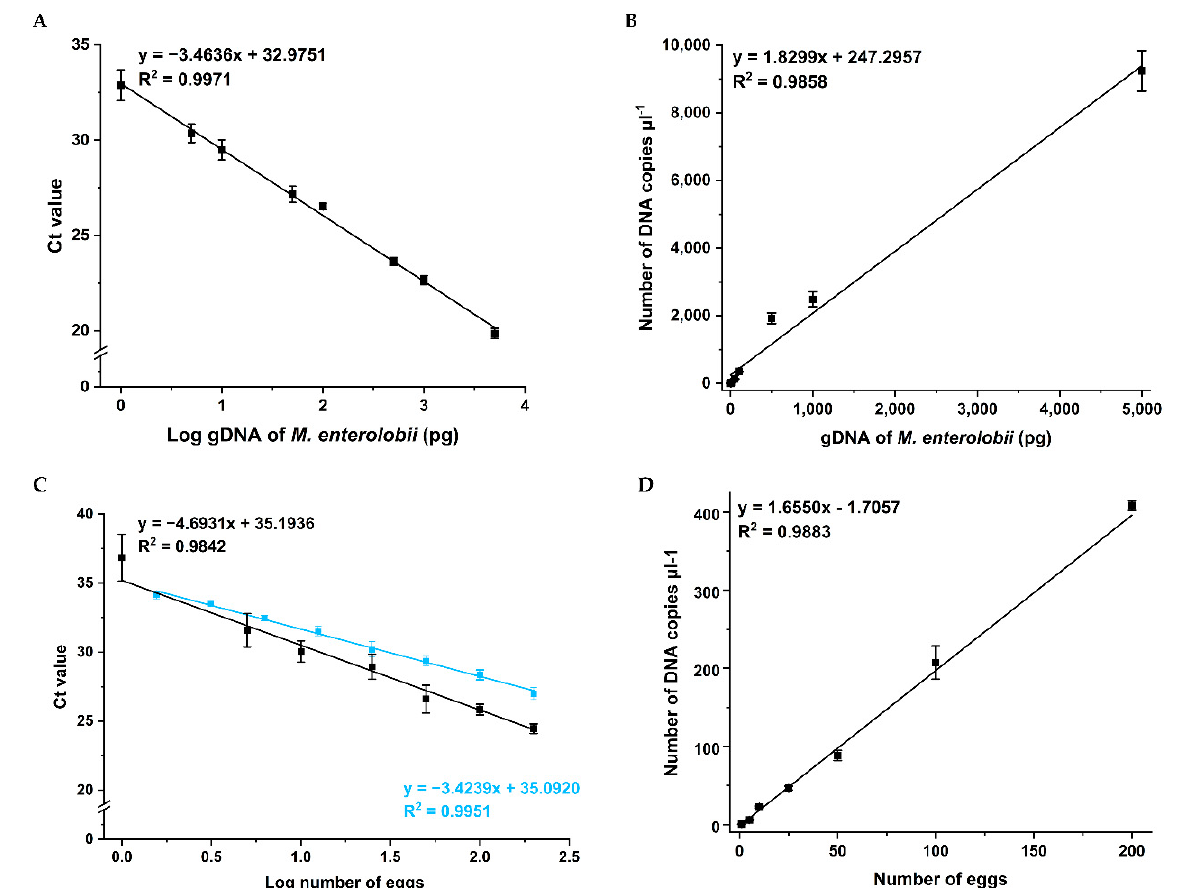
Figure 4. Regression lines for DNA samples of M. enterolobii detected by qPCR and ddPCR. ( A ) The standard curve built from Ct values obtained from qPCR against the logarithm of gDNA quantities. ( B ) The standard curve built from number of DNA copies · µ L − 1 obtained from ddPCR against the gDNA quantities. ( C ) The standard curves built from Ct values obtained from qPCR against the logarithm of number of eggs inoculated into 0.25 g of soil. The curves were generated using DNA solutions of the handpicked number of eggs added to the soil (black) or twofold dilution series of DNA solutions extracted from soil containing 200 eggs (blue). ( D ) The standard curve built from the number of DNA copies · µ L − 1 obtained from ddPCR against the number of eggs inoculated into 0.25 g of soil.